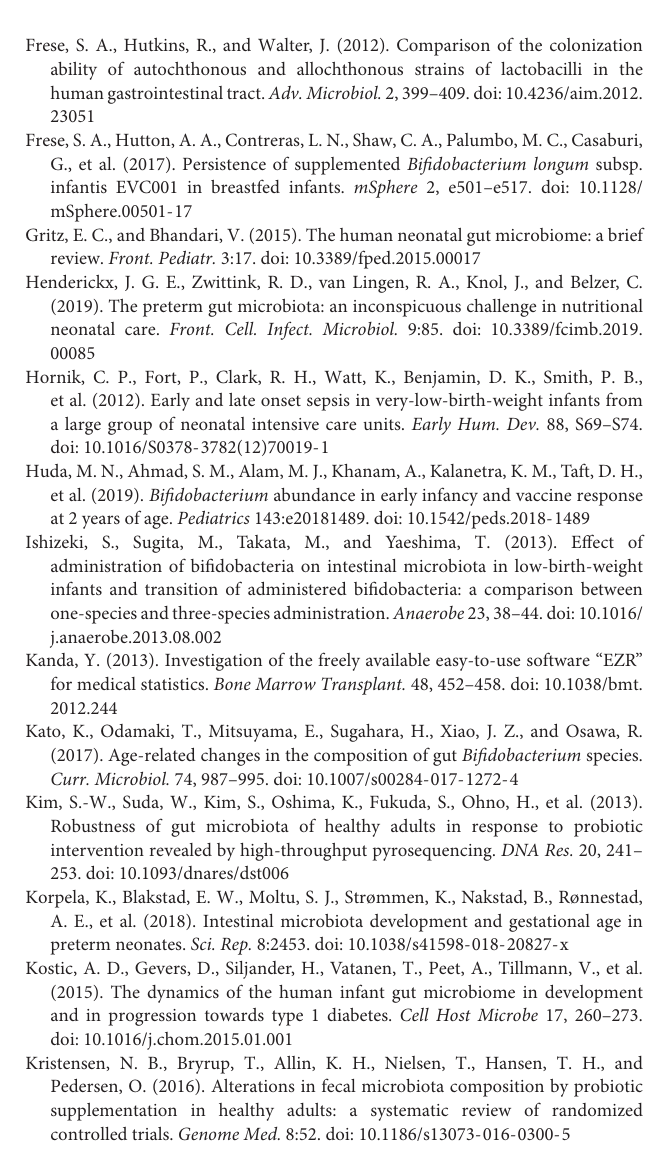
Supplementary Table 1 | Study schedule for each subject. Supplementary Table 2 | Quantitative PCR primer sets. Supplementary Table 3 | Alpha-diversity of the gut